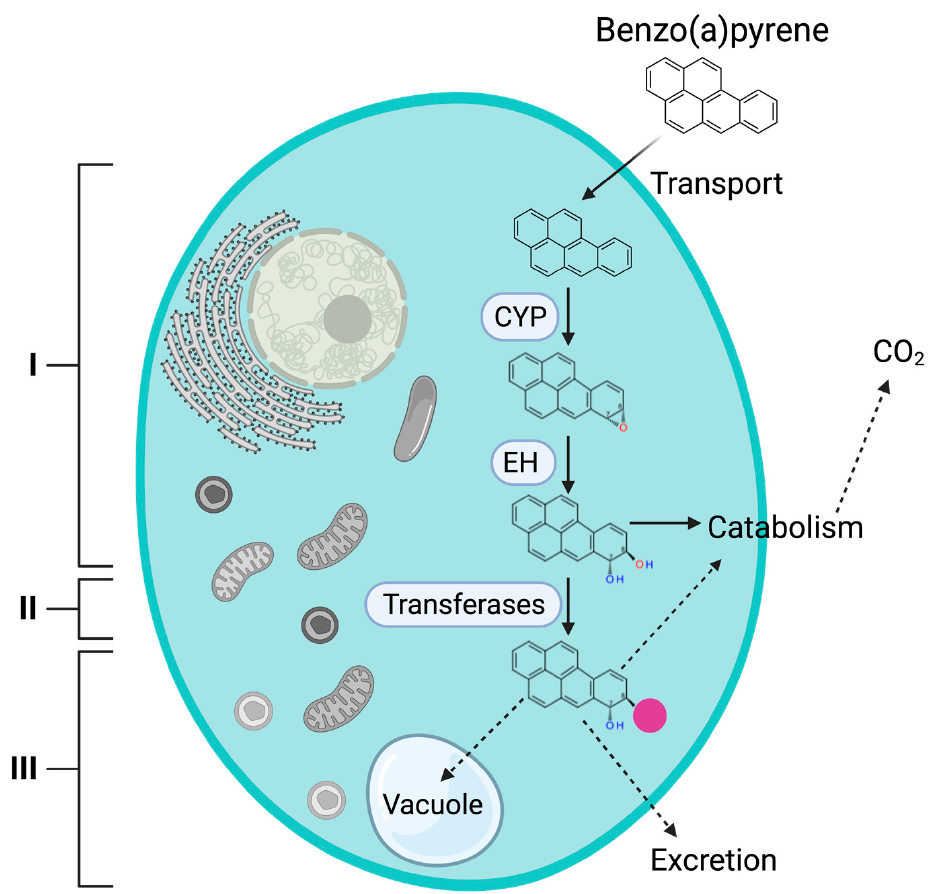
Figure 1. BaP detoxification and degradation system in yeast and other Ascomycota fungi. Phase I: BaP is transported into the cell where it is metabolized by enzymes, such as the cytochrome P450 monooxygenase (CYP) and epoxide hydrolase (EH). Phase II: Transferases (glycosyl-, sulfo-, and glutathione-S-transferases form conjugated molecules using the hydroxylated molecule as substrate (the pink circle represents the sulphate, xylose, glucose, or glutathione moiety that renders them less toxic and more soluble). Phase III: Internalization into the vacuole or excretion of the conjugated molecule and subsequent assimilation by other organisms [13]. Created with BioRender.com.